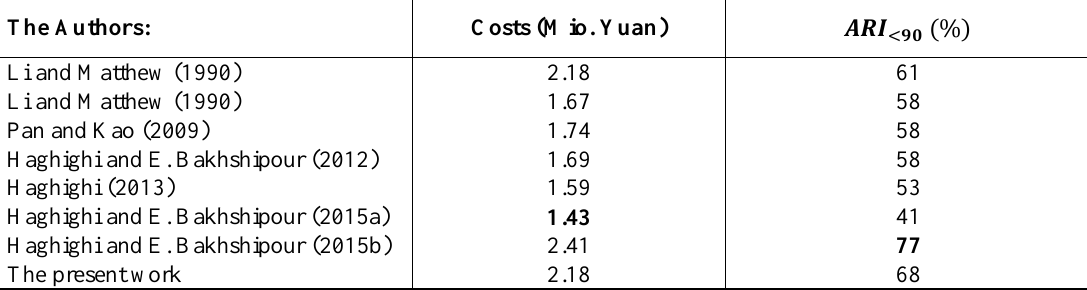
Figure 4. The optimal design, selected from the Pareto front ( 𝐀𝐑𝐈 Table 2. The reliability and cost values of the design